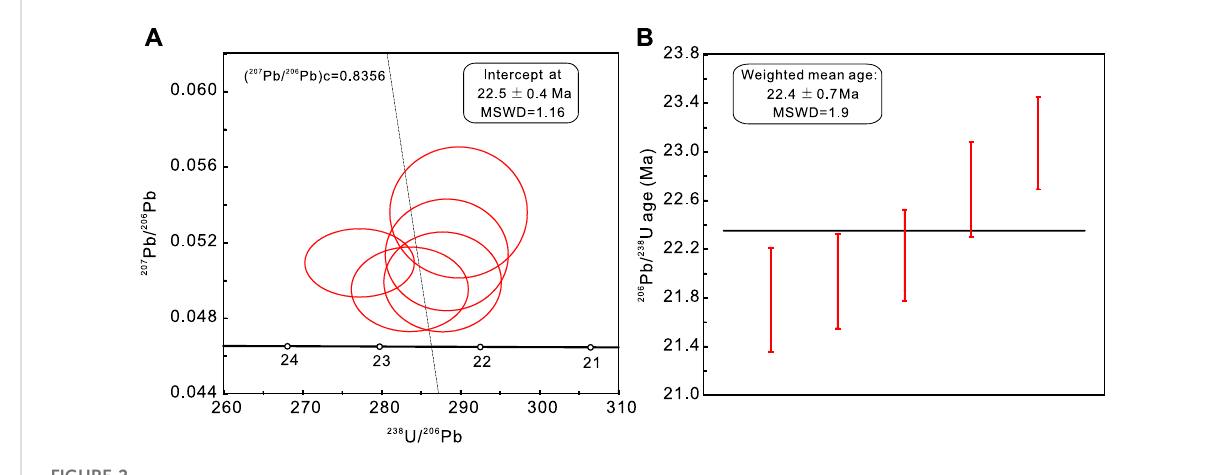
FIGURE 2 (A) Zircon U – Pb concordia age diagram for Sailipu high-K calc-alkaline trachyandesites (sample 18SLP5-1). (B) Weighted mean